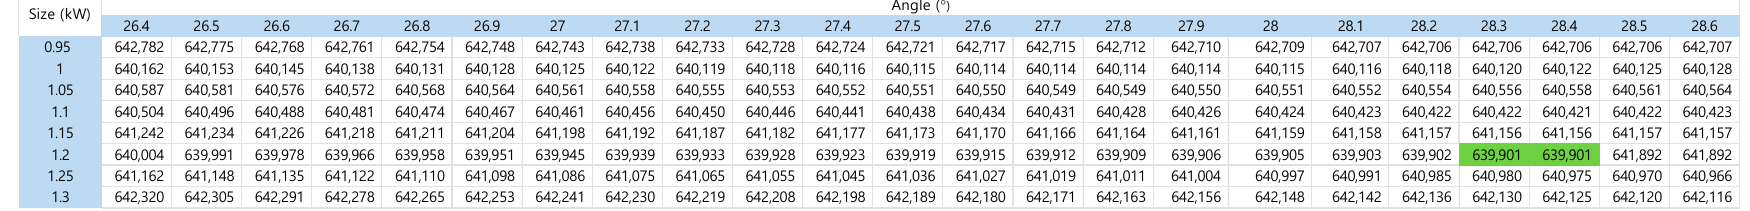
Figure 7. The total PV design cost at a finer resolution.